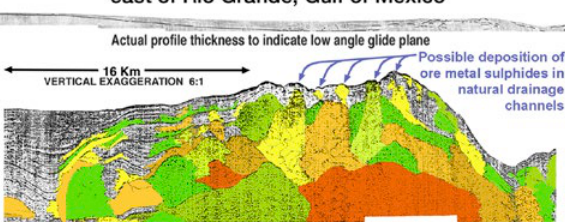
Figure 39. Seismic reflection profiles reveal a thickness of shelf sediments 900 to 1200m thick built up from successive earthquake shocks and downslope sliding. The water-rich and lighter thixotrop- ic buried sediments have then risen as complex of large sediment diapirs through the accumulated slump deposits. (Wilhelm and Ewing 14 , 1972, fig. 9.)